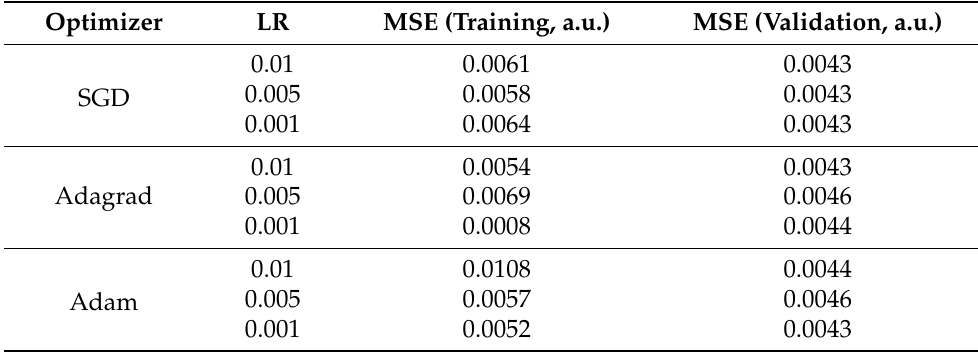
Table 1. Average mean square deviation of a neural network model of training process and verification process under different learning rates and optimizers. Optimizer LR MSE (Training,